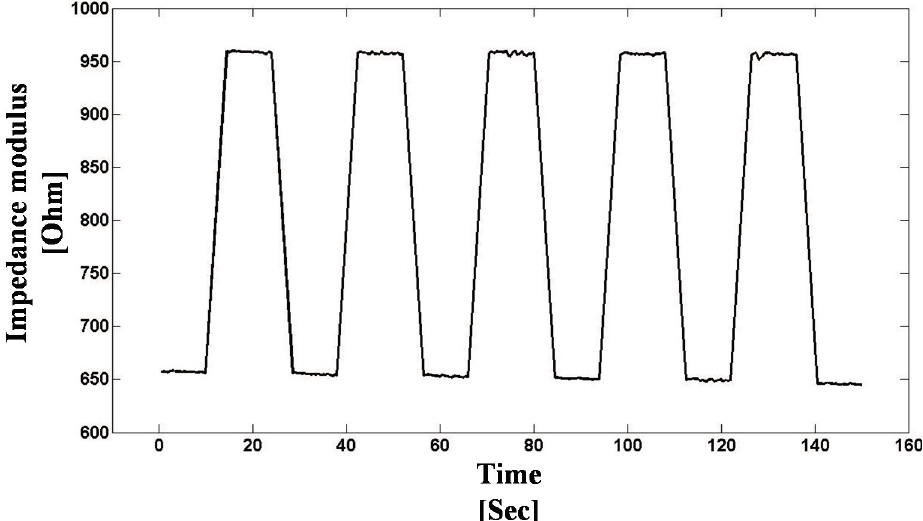
Figure 10. Touch sensing response of a 45AgI-(55- x )AgPO 3 - x WO 3 ( x = 15 mol%) glass sample recorded using the DIS platform at an AC frequency of 30 kHz, at 22 °C in ambient atmosphere. The time plot clearly resolves successive 12-s touches applied to the glass, with “touch” corresponding to higher